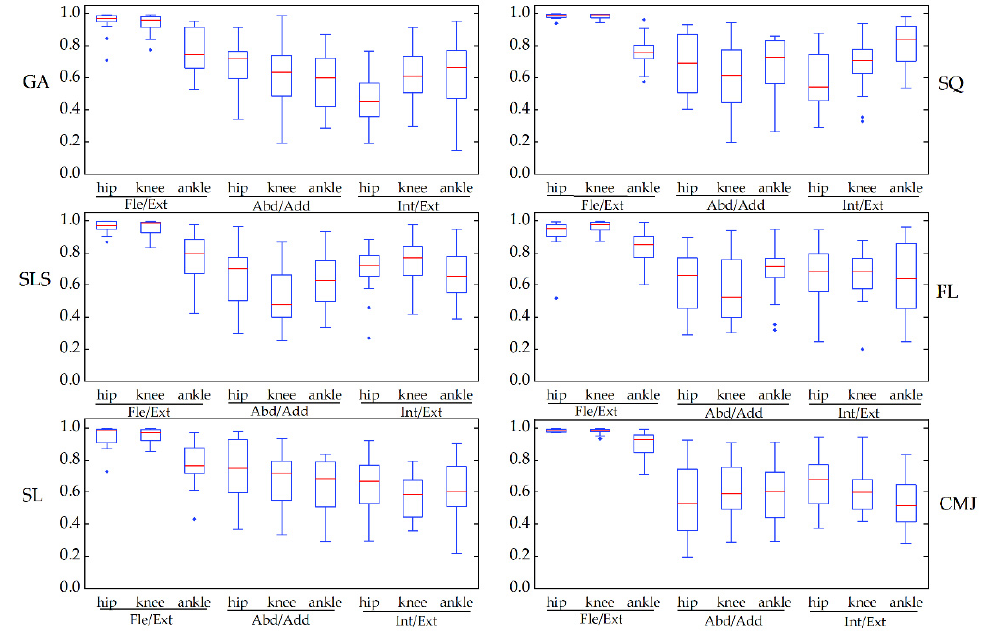
Figure 5. The waveform similarity between Perception Neuron ® system and OptiTrack system data before offset removal (CMC1) was assessed using box-and-whiskers plots of CMC values in the gait (GA), squat (SQ), single-leg squat (SLS), side lunge (SL), forward lunge (FL), and counter-movement jump (CMJ). Fle/Ext stands for “Flexion/Extension”, Abd/Add for “Abduction/Adduction”, and Int/Ext for “Internal/External Rotation”.